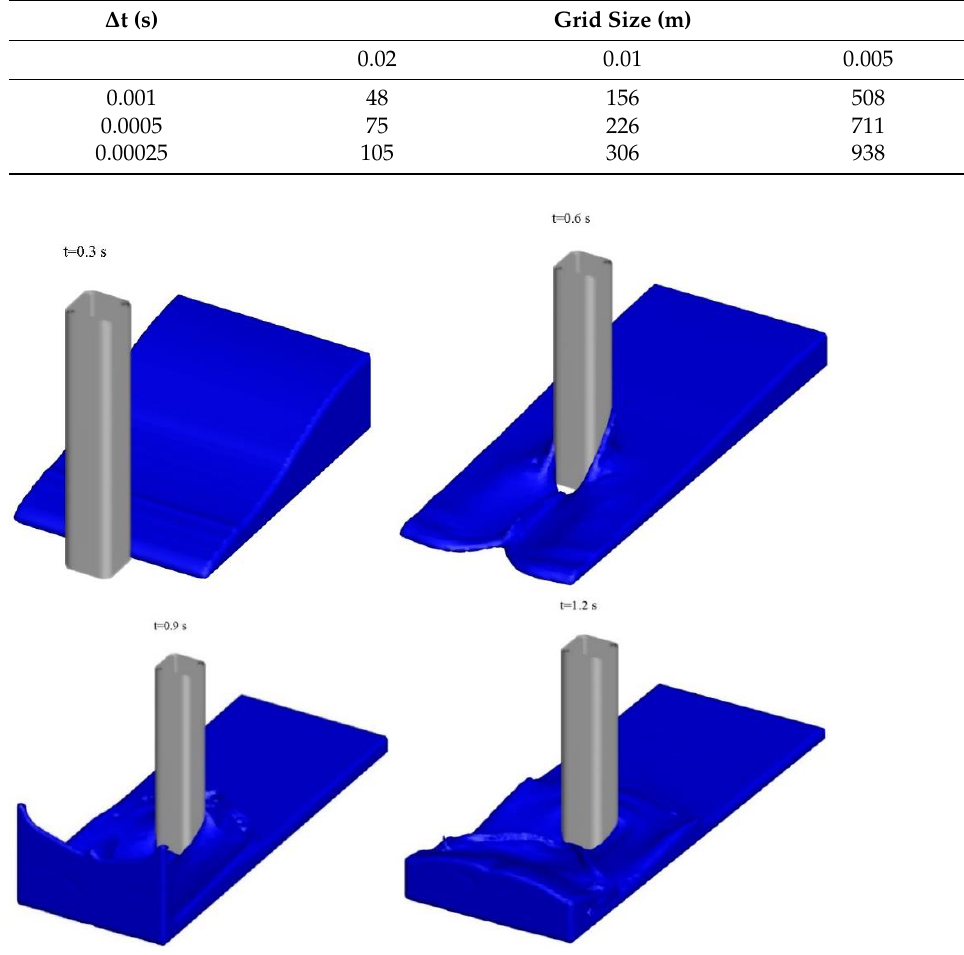
Figure 4. Time history of the horizontal velocity upstream the square obstacle at the location (0.754, 0, 0.026). Figure 5. Time history of the impact force on the square obstacle.